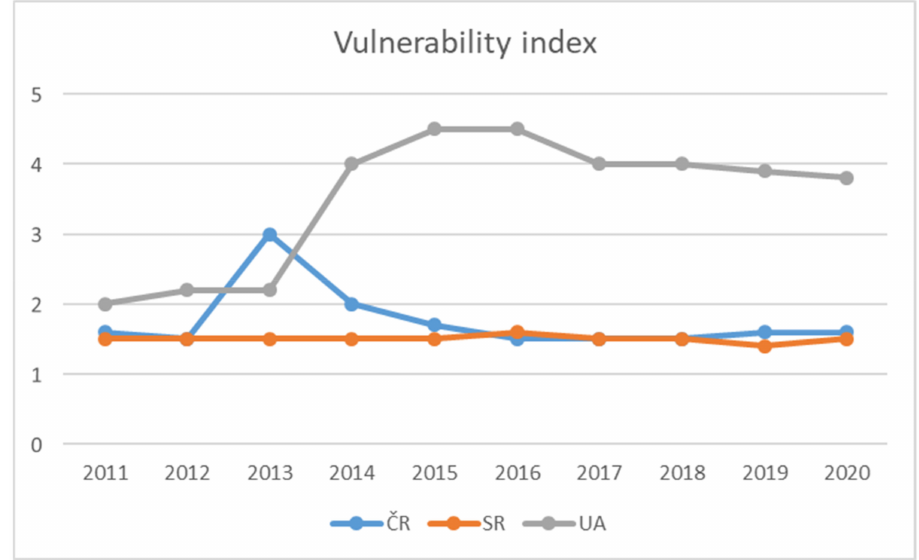
Figure 2. Vulnerability values of the SR, CZ and UA in 2011–2020